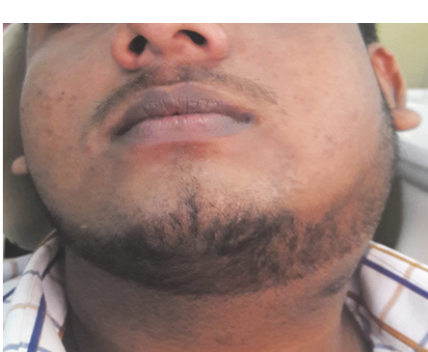
Figure 1: L/S neck swelling due to lymphadenopathy.